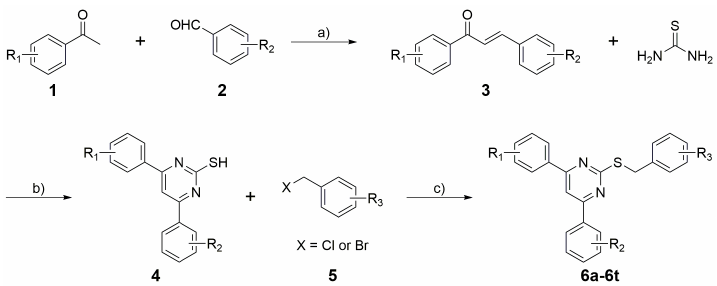
Figure 1. The structures of some commercial drugs containing pyrimidine pharmacophore.